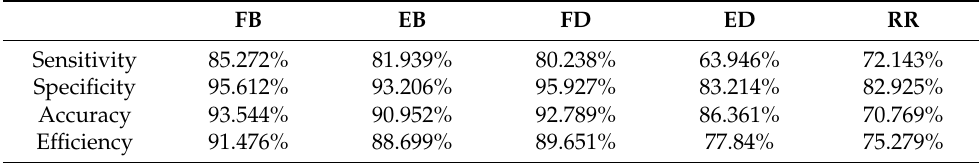
Table 14. Classifier performance parameters for the blind validation